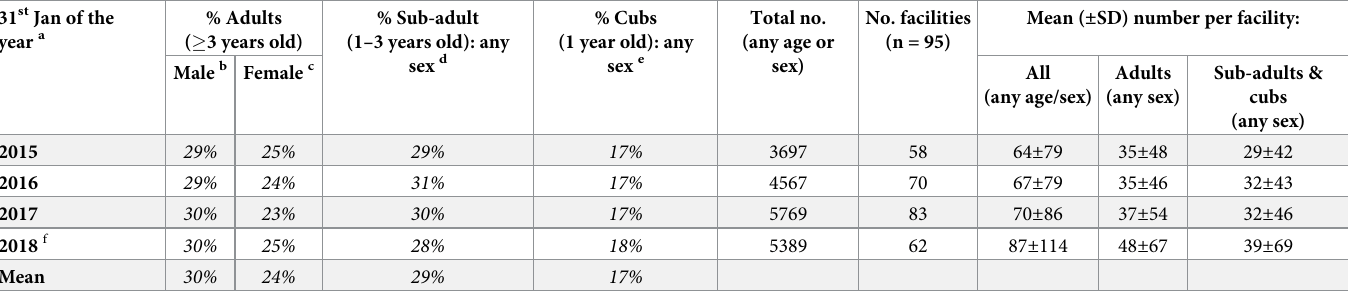
Table 4. Total proportion of lions listed by all responding facilities per age and/or sex group. The number of responding facilities differs annually, and 95 respondents provided data for � 1 year. Results for the proportion and range in the number of lions per facility, facility type, and the proportion per province are in Tables H–J of S1 Tables. Results correspond to Questions